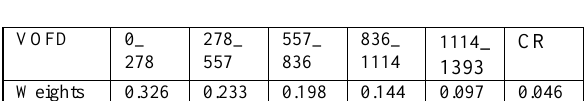
Table 6. Weights of group FAHP for subclasses of HOFD